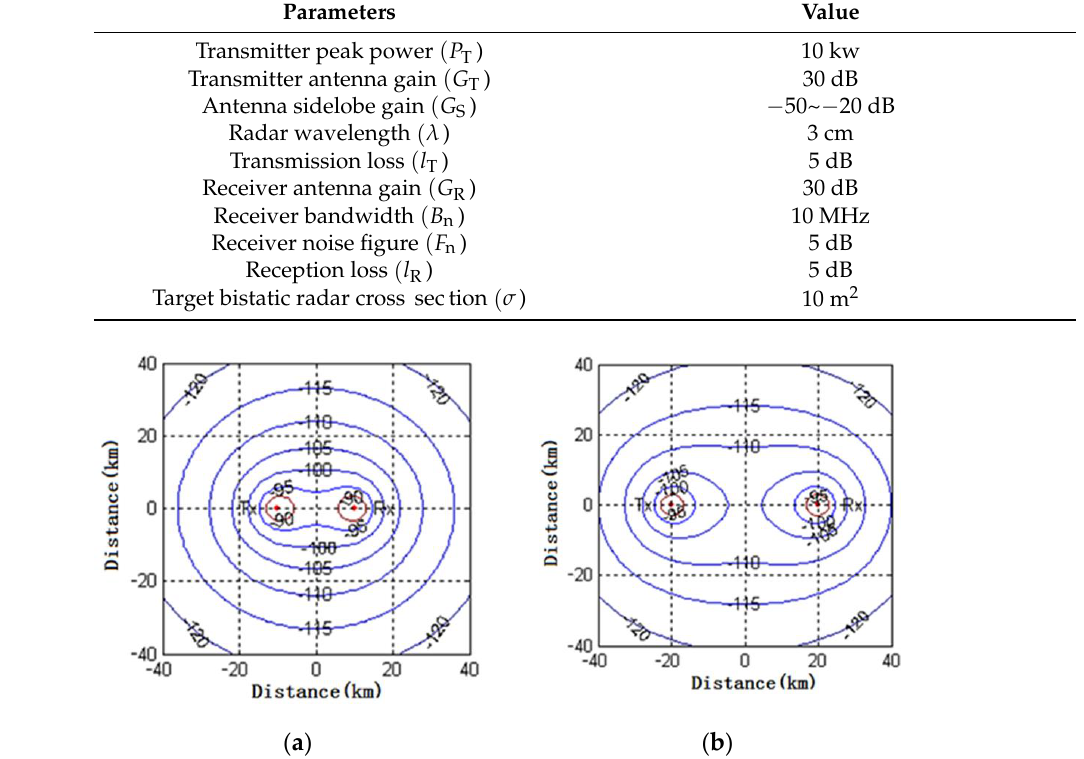
5 of 24 Table 1. Typical working parameters of the HBR system. Parameters Value Transmitter peak power ( T P ) 10 kw Transmitter antenna gain ( T G )